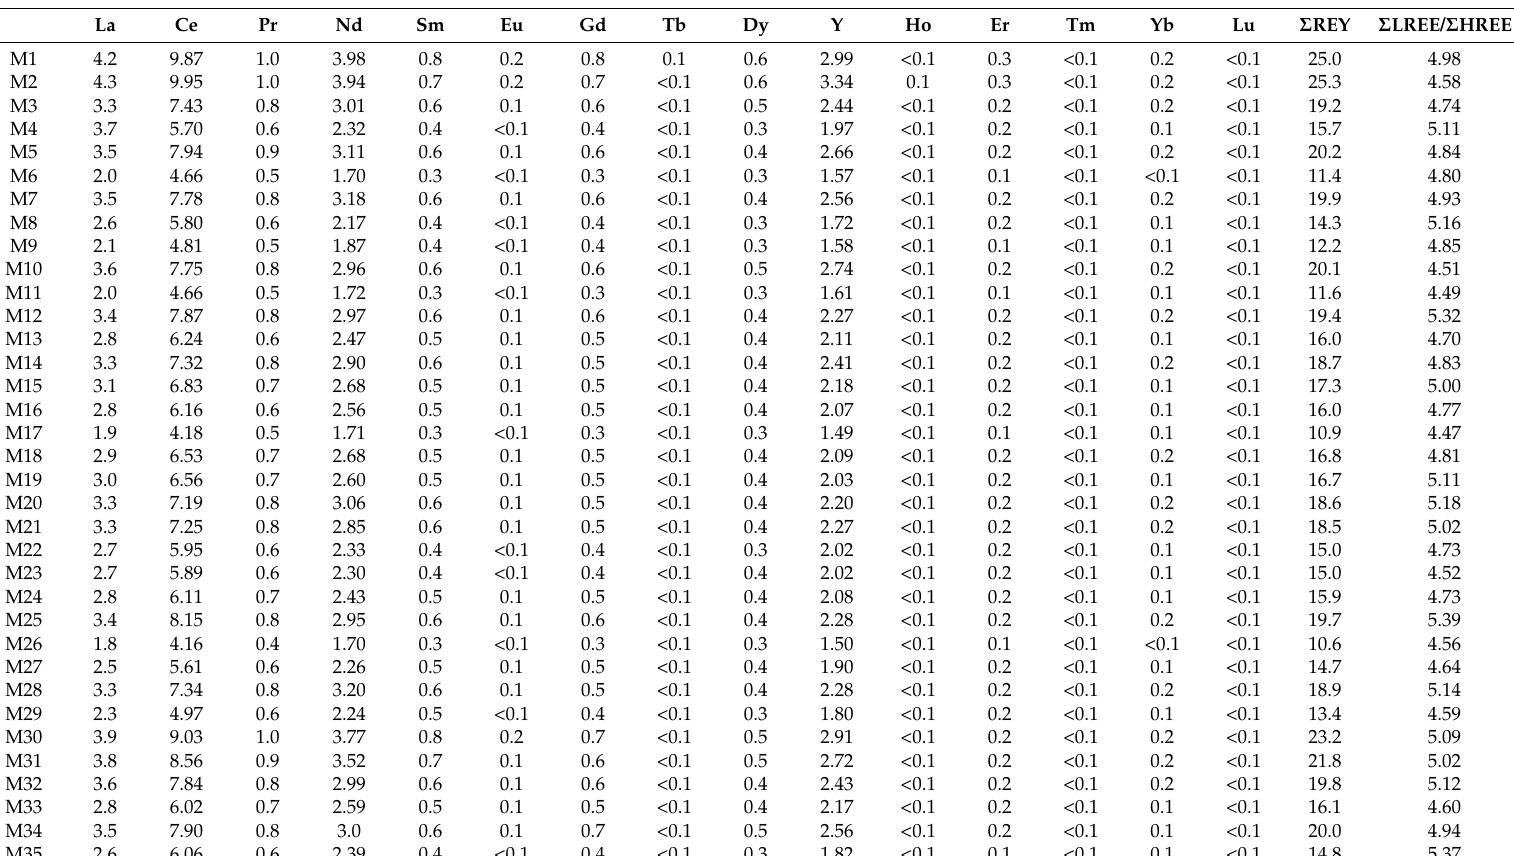
Table A3. Concentrations of rare earth element Y (REYs), expressed in mg kg − 1 , in the Lake Mir sediments (M1–M35). LREE—light rare earth elements; HREE—heavy rare earth